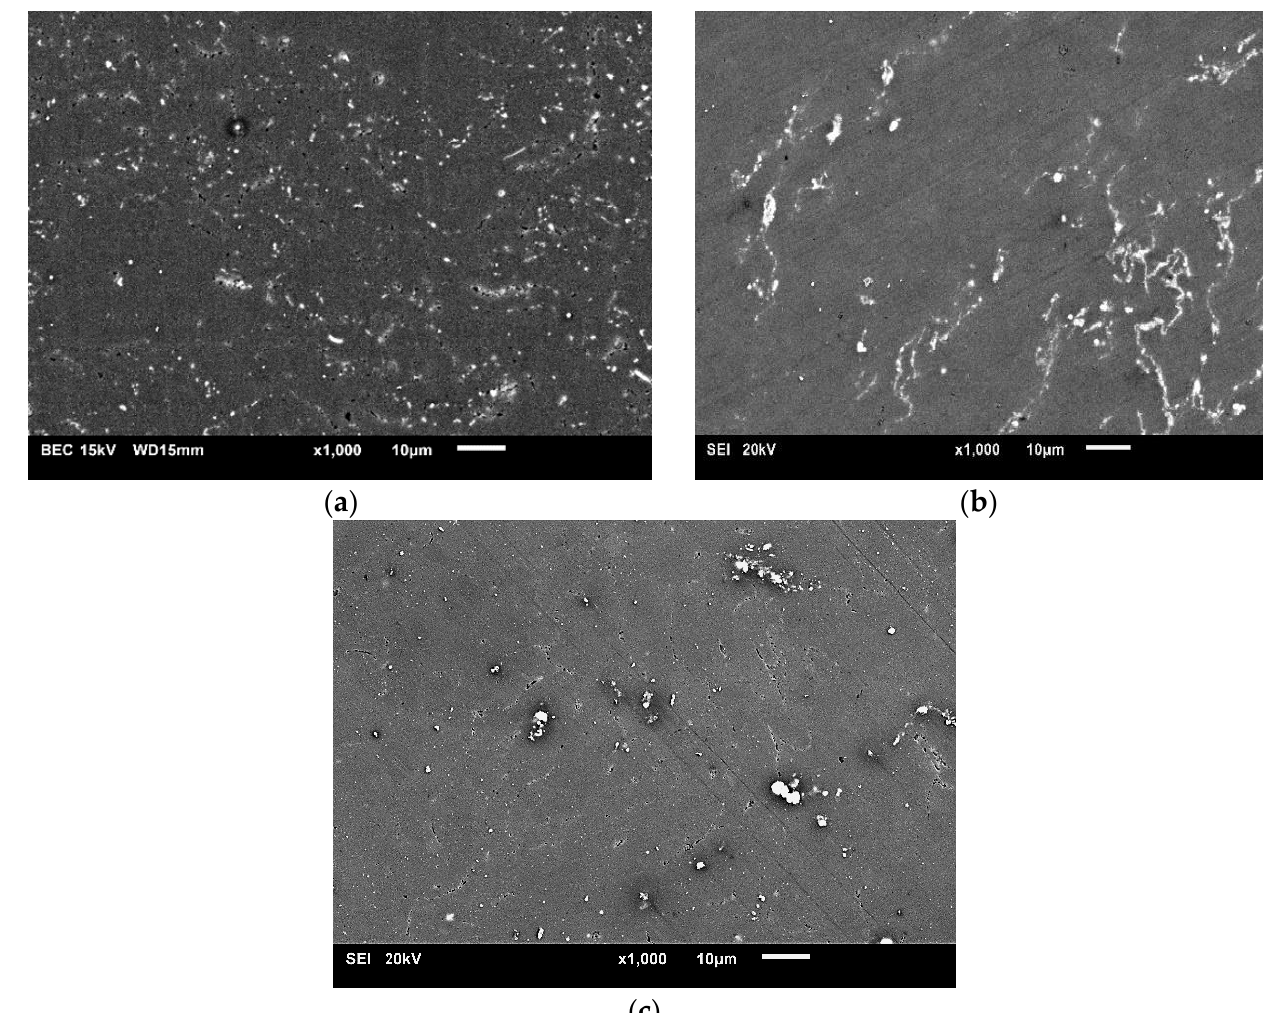
Figure 1. Formation, distribution, and morphology of secondary phases in: ( a ) Mg1Ca alloy, ( b ) Mg1Ca1Sc alloy, and ( c ) Mg1Ca1Sc/B 4 C composite.